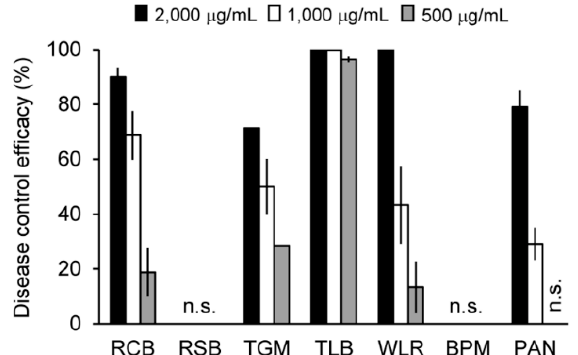
Figure 3. Phylogenetic analysis of the IUM00035 isolate. Phylogenetic analysis was performed based on the ITS region of IUM00035 and the other 20 Crinipellis species. The neighbor-joining method was used for this analysis, and numbers at the nodes indicate the levels of bootstrap support (%) by 1000 resampled datasets. NCBI accession numbers of each sequence are in parentheses. Bar, 5 substitution per 1000 nt.